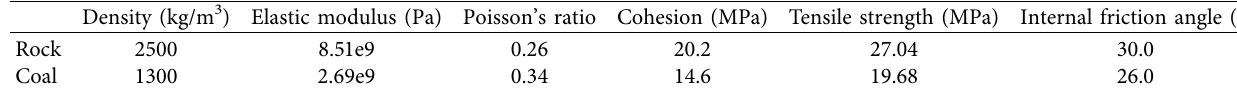
Figure 8: Numerical models and boundary conditions. Table 3: Micromechanical parameters of coal-rock